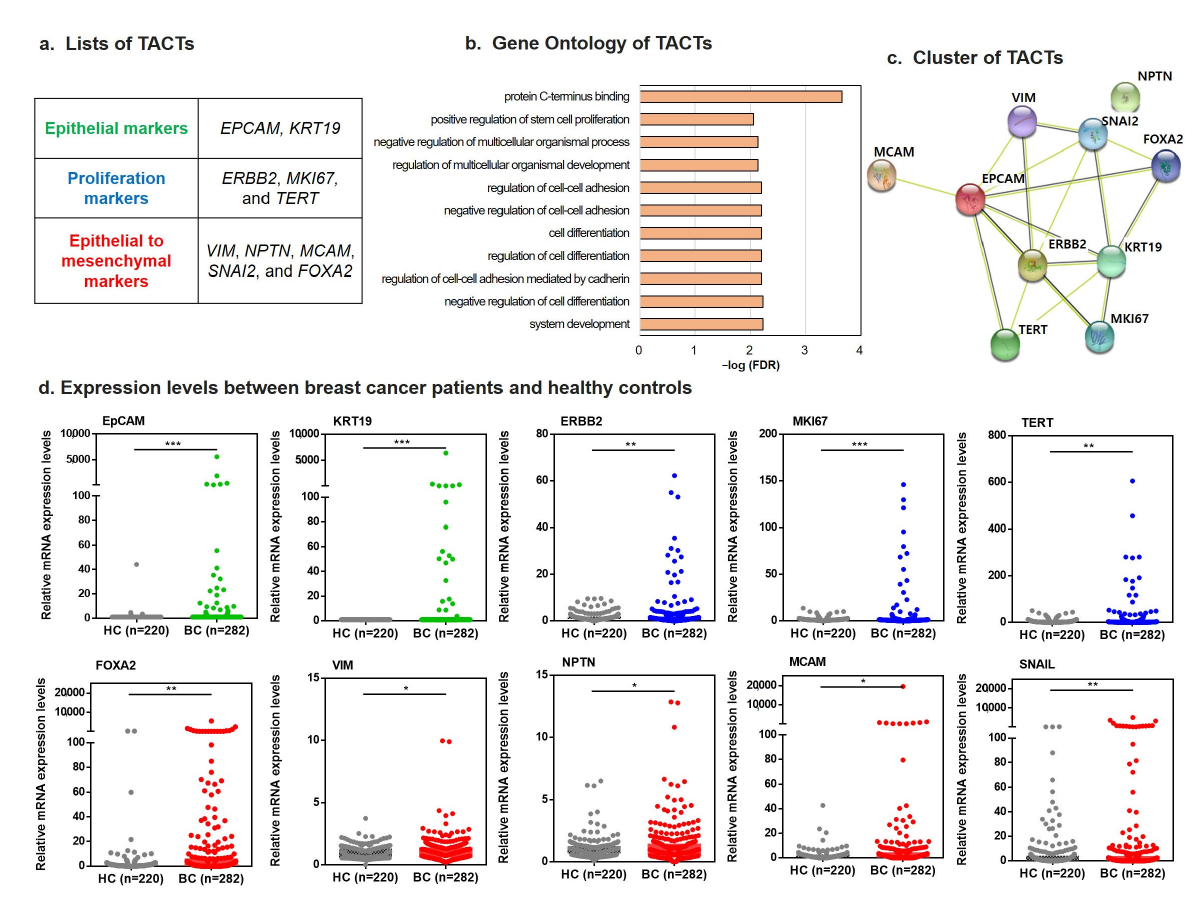
Figure 2. Identification of TACTs. ( a ) Classification of 10 significant transcripts according to epithelial, proliferation, and epithelial-to-mesenchymal features. ( b ) Gene Ontology analysis of TACTs to determine biological and molecular function. ( c ) Interaction network of the 10 TACTs. ( d ) mRNA expression levels of each TACT in healthy controls (HCs) and breast cancer patients (BC). * p < 0.05, ** p < 0.01, *** p < 0.001.